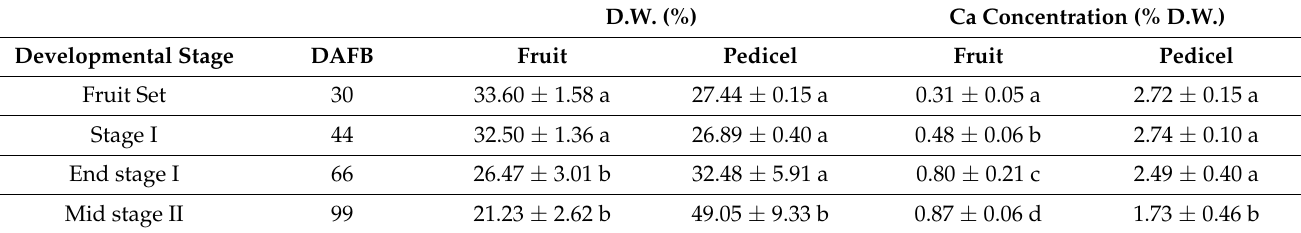
Table 2. Dry weight (D.W., %) and Ca concentration (% D.W.) in whole fruit and pedicel (data are means ± standard deviations, SD). Within columns, values marked with different letters are significantly different according to Duncan’s Multiple Range Test ( p ≤ 0.05).